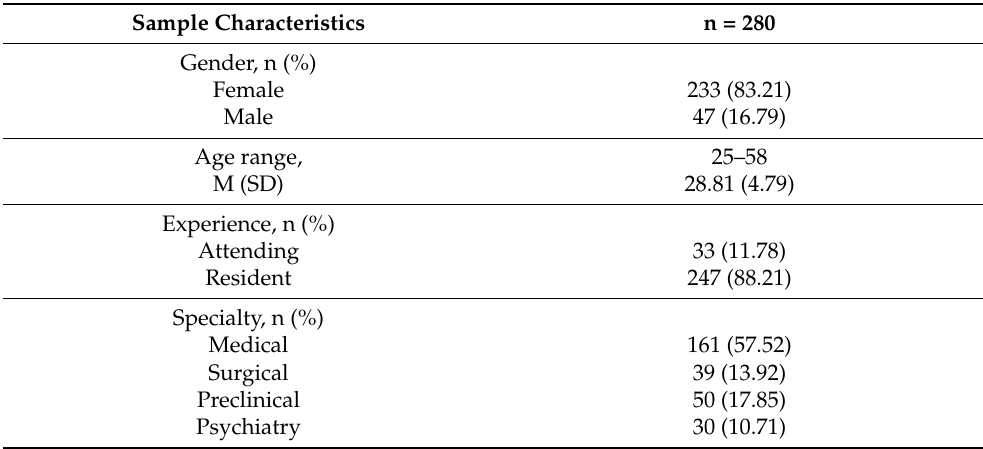
Table 1. Demographic characteristics of the sample.